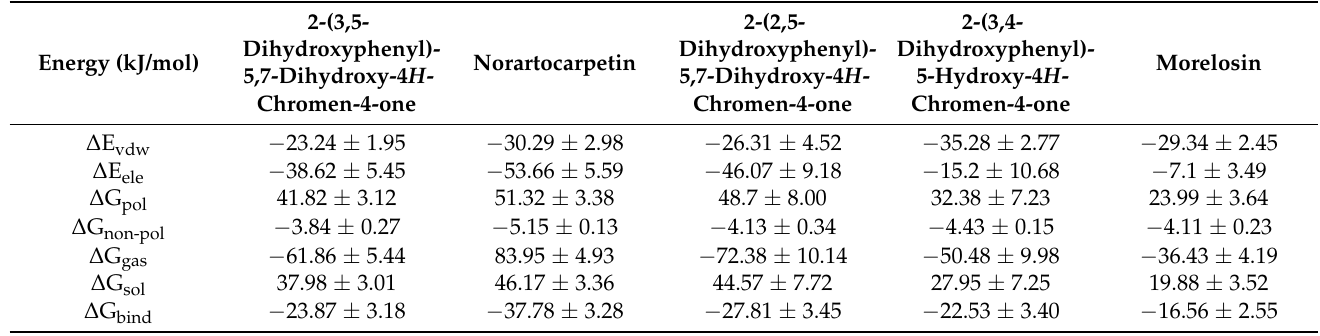
Table 4. Binding free energy of complex formation between α -glucosidase and its inhibitors.